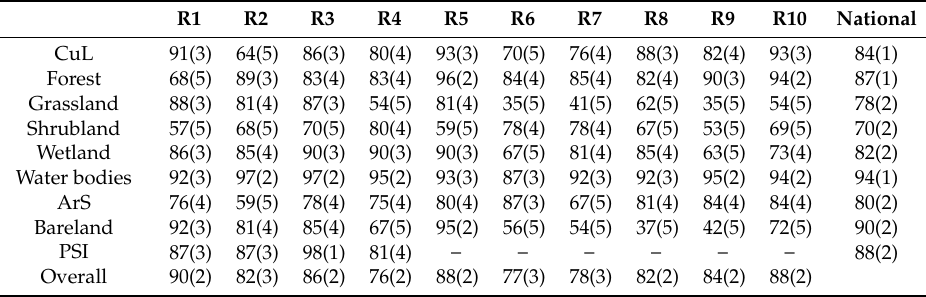
Table 5. Regional user’s accuracies for nine land cover classes with standard errors (SE) in parentheses. Agreement is defined as a match between the map class and either the primary or alternate reference class (Cultivated land is abbreviated as CuL, Artificial Surfaces is abbreviated as ArS, Permanent snow and ice is abbreviated as PSI; – means there is no permanent snow and ice in a given region; Column “National” represents countrywide user’s accuracies).